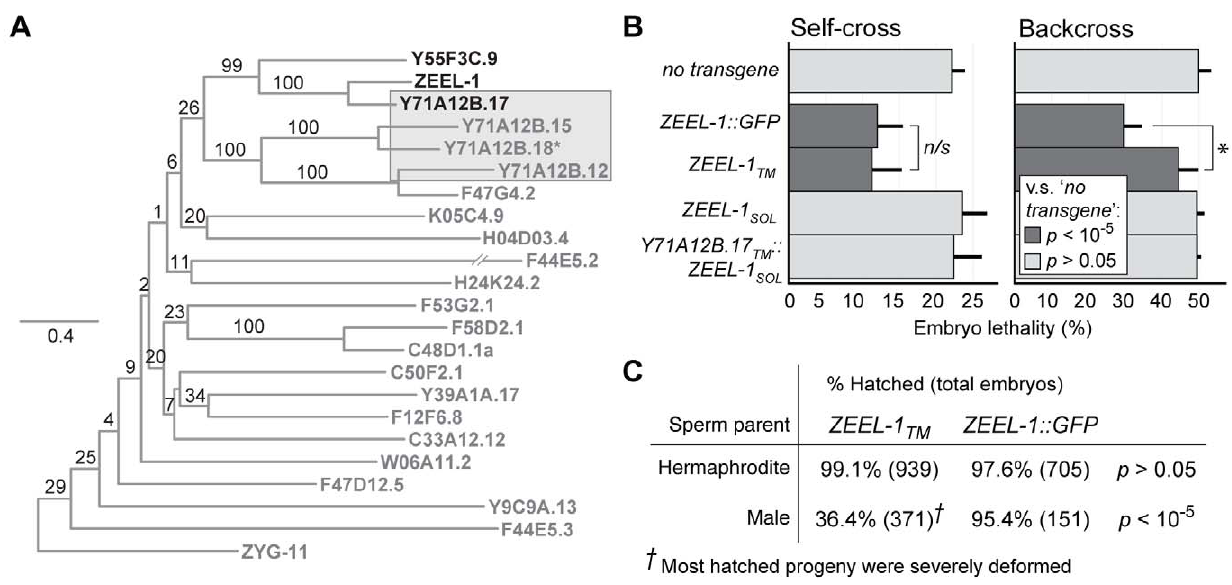
Figure 7. The transmembrane domain of zeel-1 is evolutionarily novel and partially sufficient for function. (A) Maximum likelihood phylogeny of the protein sequences of all zyg-11 homologs in C. elegans . Genes containing predicted transmembrane domains are highlighted in black. The transmembrane domains of these genes were excluded prior to analysis. Genes located in the tandem array are highlighted by a shaded grey rectangle. Scale bar indicates amino acid substitutions per site. Values on branches indicate percent bootstrap support. The asterisk indicates that the reference sequence of Y71A12B.18 contains a single frame-shift, corrected prior to analysis. (B) Four zeel-1 -derived transgenes were introduced into a strain carrying the zeel-1 deficiency, niDf9 , and tested for their ability to rescue peel-1 -affected embryos. To test for rescue, transgenic animals were crossed to the Bristol strain, and lethality was scored among embryos derived from self-fertilizing F1 hermaphrodites (self- cross) and F1 males backcrossed to hermaphrodites of the original transgenic line (backcross). For each type of transgene, 4 to 13 independent extra- chromosomal arrays were tested. For each array, 100 to 600 embryos were scored per self-cross or backcross. Ten control replicates were performed in parallel, each including 100 to 400 embryos (‘‘no transgene’’ bars). Among arrays or control replicates, lethality scores were averaged to obtain global means and standard deviations. Each transgene was tested for a reduction in lethality compared to the control replicates (Student’s t tests, p values indicated by shading). Additionally, the two rescuing transgenes ( ZEEL-1 TM and ZEEL-1::GFP ) were tested for significant differences relative to one another (Student’s t tests; * p , 0.005; n/s , p . 0.05). For the rescuing transgenes, lethality was not reduced to zero because extra-chromosomal arrays are not transmitted to all progeny. (C) Hatch rates were compared between peel-1 -affected embryos that we confirmed to have inherited either ZEEL-1 TM or ZEEL-1::GFP ( x 2 tests, p values shown). Separate comparisons were performed for male- and hermaphrodite-sired embryos. Unless otherwise specified, all hatched progeny appeared morphologically normal. Inheritance of the transgenes was determined by expression of the co- injection marker, Pmyo-2::RFP . Sibling embryos not inheriting the transgene were used as internal negative controls. The hatch rates of these controls were 2% ( n =601 2 653) among hermaphrodite-sired embryos and 0% ( n =341 2 933) among male-sired